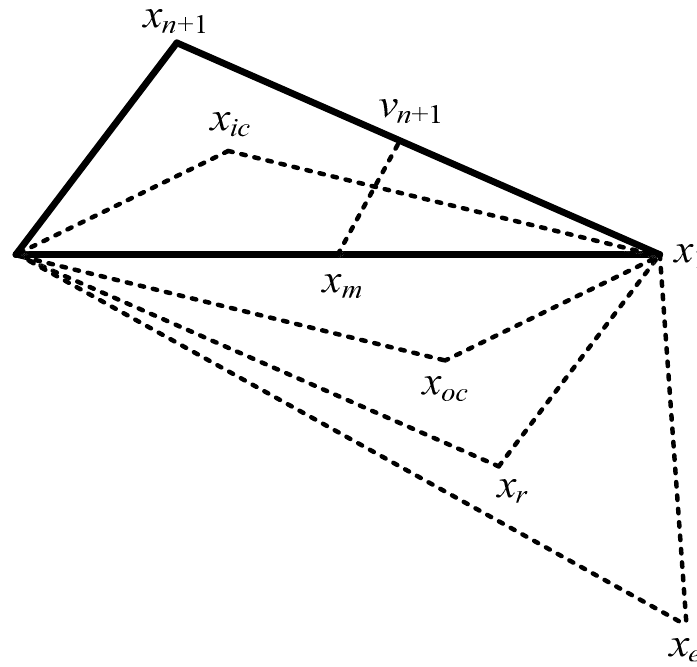
Figure 2. Pictorial description of Nelder–Mead (N–M) simplex method.